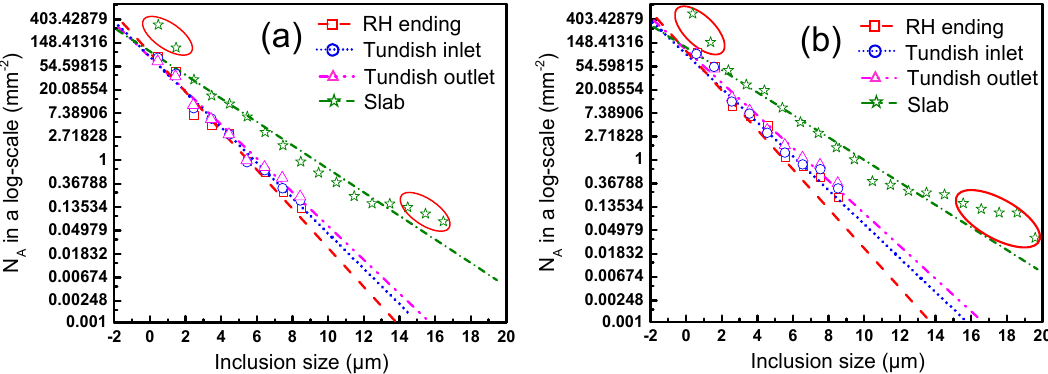
Figure 10. PSD of inclusions in a log-scale at the di ff erent steelmaking stages for Steels ( a ) A and ( b ) B. Table 3. Parameters of regression lines by PSD at the di ff erent steelmaking stages for Steels A and B.